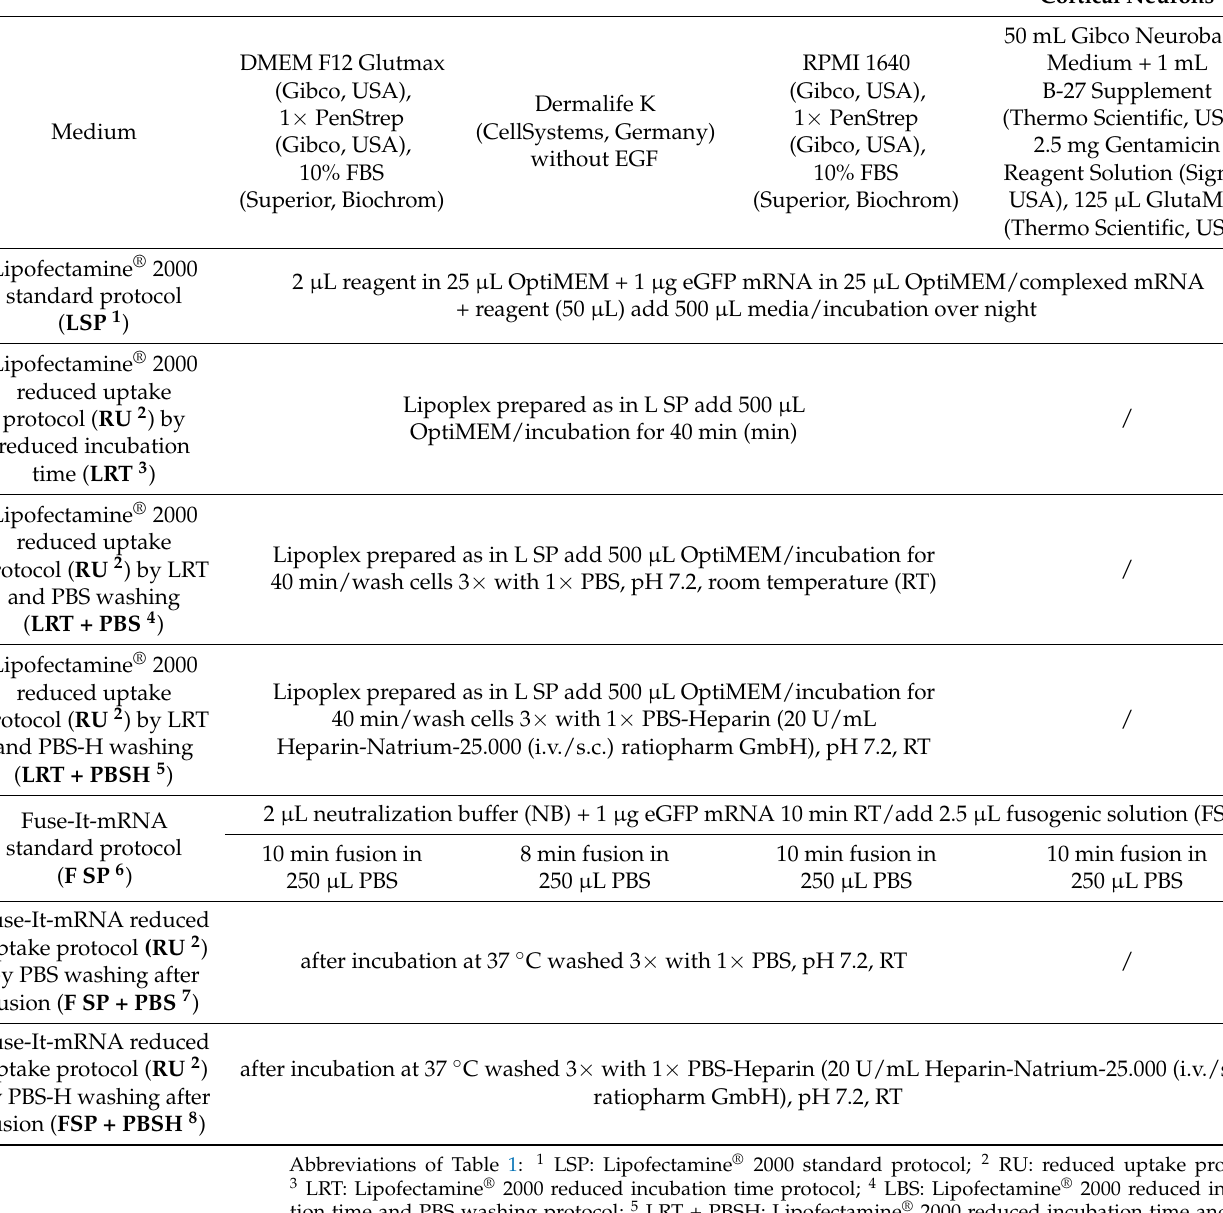
Abbreviations of Table 1: 1 LSP: Lipofectamine ® 2000 standard protocol; 2 RU: reduced uptake protocol; 3 LRT: Lipofectamine ® 2000 reduced incubation time protocol; 4 LBS: Lipofectamine ® 2000 reduced incuba- tion time and PBS washing protocol; 5 LRT + PBSH: Lipofectamine ® 2000 reduced incubation time and PBS supplemented with Heparin washing protocol; 6 FSP:Fuse-It-mRNA standard protocol; 7 FSP + PBS: Fuse-It- mRNA standard and PBS washing protocol; 8 FSP + PBSH: Fuse-It-mRNA standard and PBS supplemented with Heparin washing